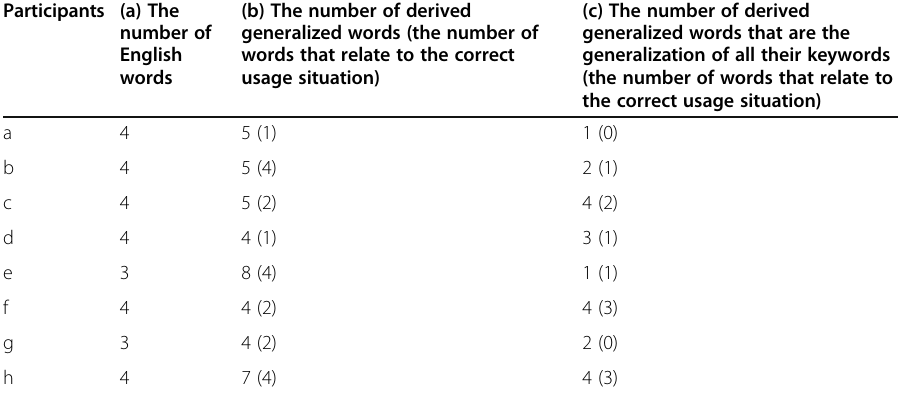
Table 6 The learning result of Word B using the system Participants (a) The number of English